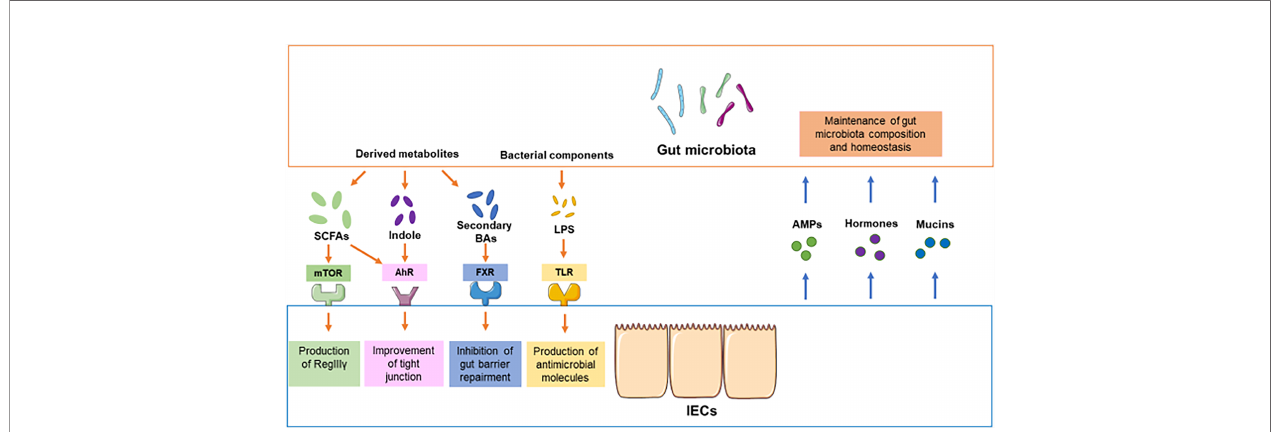
FIGURE 1 | Crosstalk between the gut microbiota and IECs under physiological conditions. In physiological conditions, the components of the gut microbiota and derived metabolites compromise or destroy intestinal barrier integrity through different pathways, such as mTOR, AhR, FXR and TLR. For instance, SCFAs promote the production of RegIII g and defensins from IECs by activating mTOR. The activation of SCFAs and indole can improve the function of tight junctions. The components of the gut microbiota, such as LPS, promote the production of antimicrobial molecules in IECs. On the other hand, secondary bile acids from gut microbiota may inhibit the repair of the gut barrier. Conversely, IECs can modulate the composition of gut microbiota by providing some signaling molecules or alternative energy resources, including AMPs, hormones, and